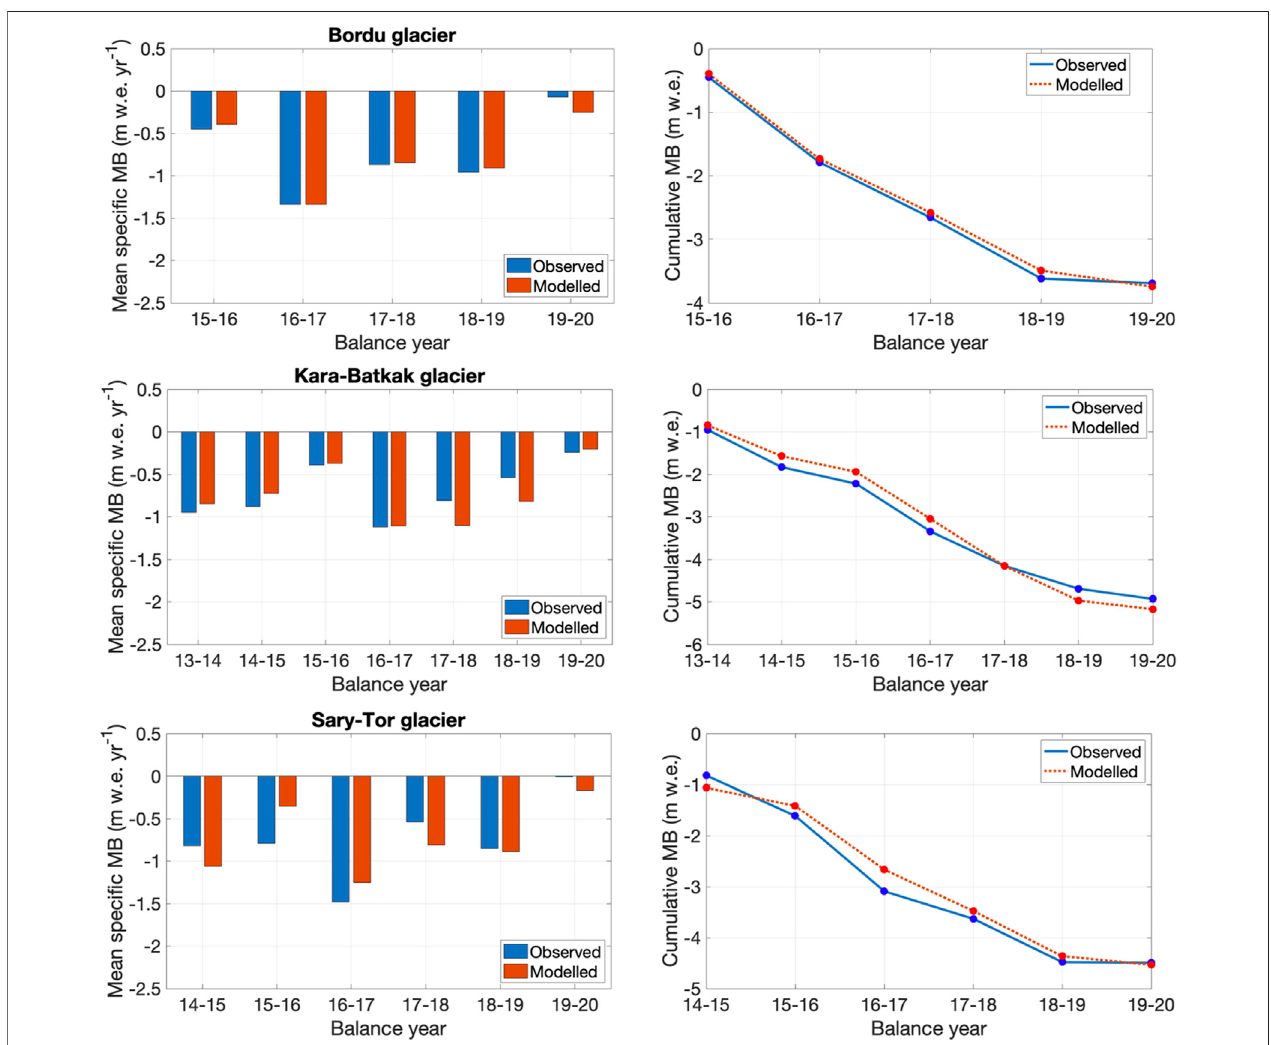
FIGURE10| Leftpanels: Modelled and observed mean speci fi cmassbalance (MB)for every balance year(in m w.e. yr − 1 ).Rightpanels: Cumulative mean speci fi c mass balance for the corresponding period (in m w.e.).